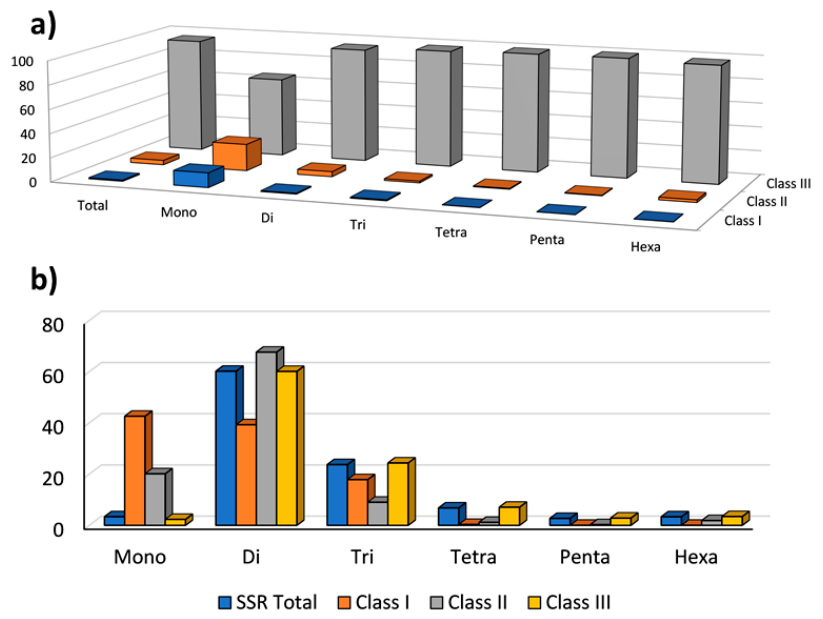
Figure 3. ( a ) The frequency of repeat classes (class I > 30 motif repeats, class II 20–30 motif repeats, class III < 20 motif repeats; ( b ) the distribution of motif type within each